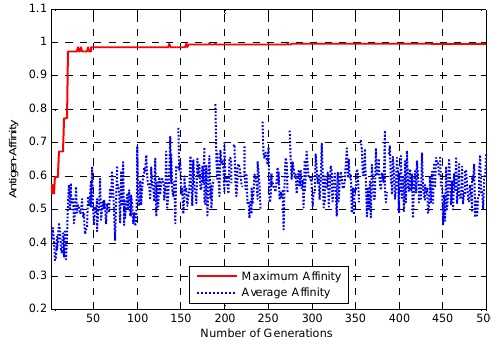
Fig. 12. Sensitivity of Population Size N.